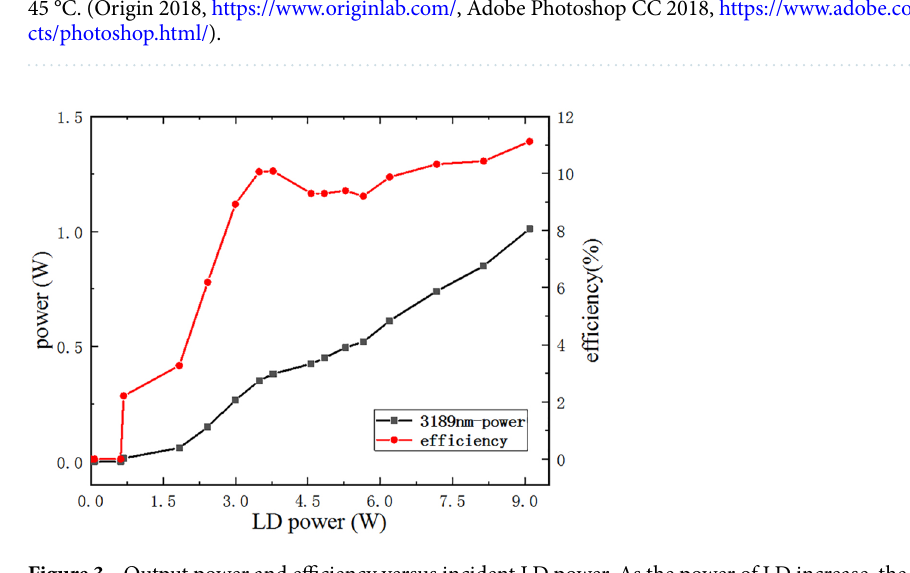
Figure 3. Output power and efficiency versus incident LD power. As the power of LD increase, the output power of idler rises and the efficiency increase except for 4 W. (Origin 2018, https ://www.origi nlab.com/,